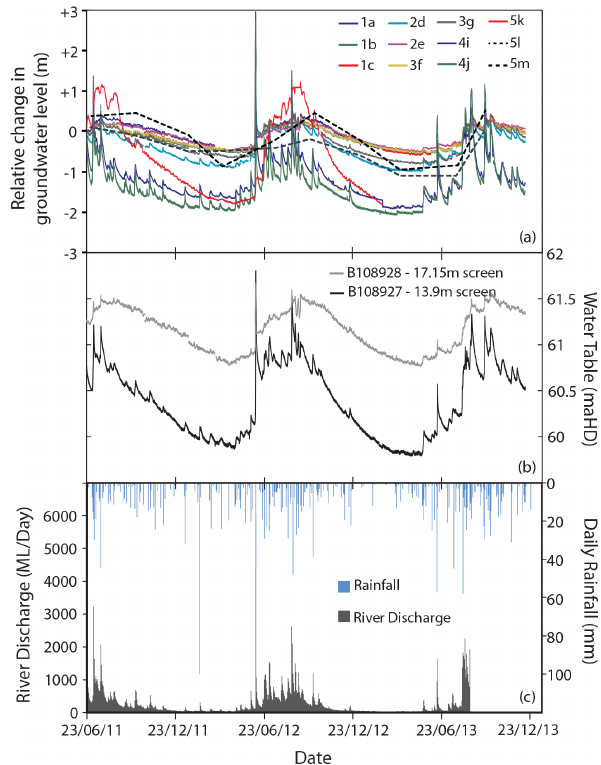
Figure 2. (a) Groundwater elevations in bores display clear annual cycles. (b) Groundwater head-gradients in the Gellibrand Valley are upwards, implying a discharge zone (Victorian Water Resources Data Warehouse, 2013). (c) Flow in the Gellibrand River. Baseflow conditions during summer months transition into high flows in win- ter following winter rainfall (Bureau of Meteorology,